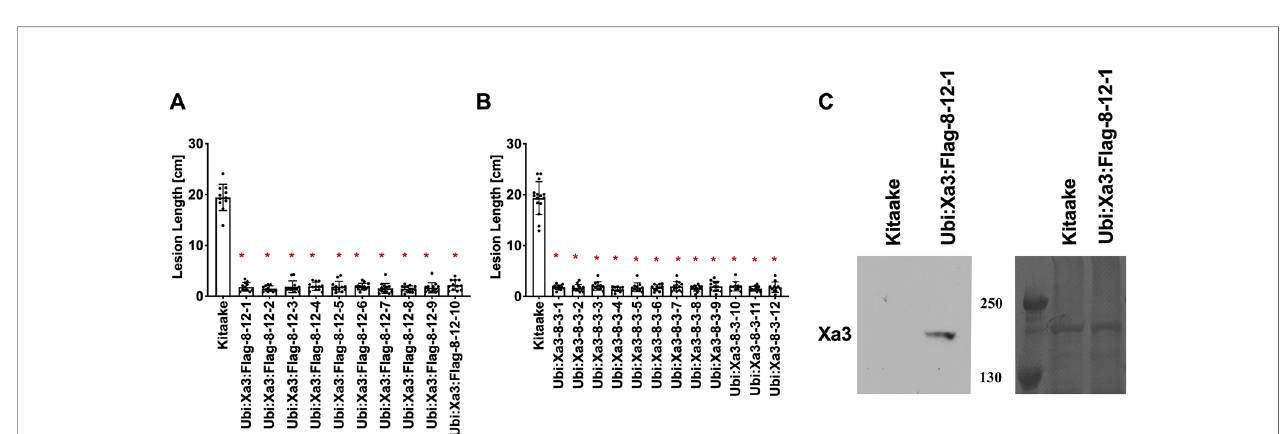
FIGURE 3 | T2 lines derived from T1 parents Ubi : Xa3-8-3 and Ubi : Xa3 :Flag- 8-12 are resistant to PXO79. The inoculation method was described in Figure 1 . Bars represent means of 8 – 12 leaves. “ * ” indicates statistically a signi fi cant difference from Kitaake using Dunnett's test ( a = 0.05). (A) Lesion length data for 10 T2 plants of Ubi : XA3: Flag -8-12 . (B) Lesion length data for twelve T2 plants of Ubi : XA3-8-3 . (C) Western blot analysis of total protein extracted from fi ve-week-old Kitaake and Ubi : Xa3: Flag -8-12-1 . The experiment was repeated three times. The full-length XA3 was detected with an anti-Flag antibody (left). Approximately equal amounts of total proteins were loaded, as con fi rmed by Coomassie blue staining (right).